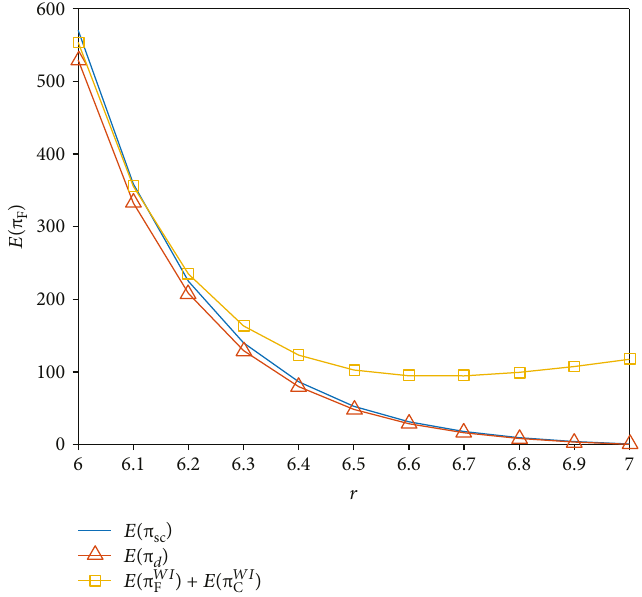
Figure 11: E ff ect of r on decentralized and centralized supply chain performance before and after WI , φ , T .